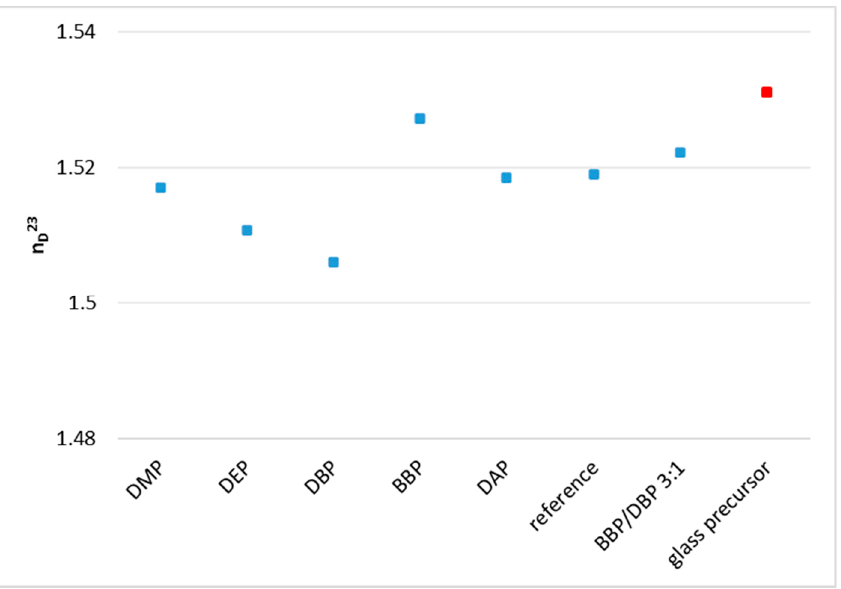
Figure 9. Refractive indices of the respective mixtures of each phthalate, the dispersing agent Solplus K500, and the monomer mixture of SR348C and SR833S.